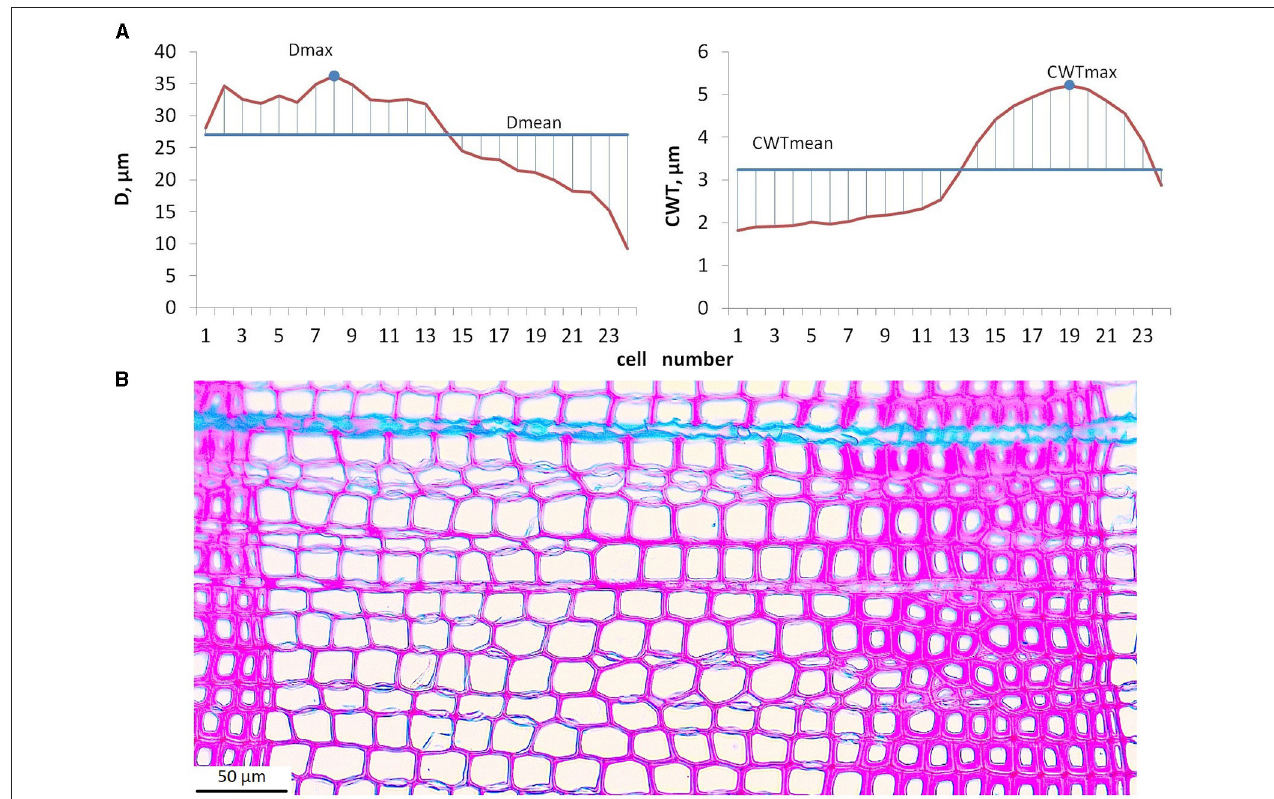
FIGURE 2 | Calculation procedure for maximal and mean values of cell traits: averaged tracheidograms of radial diameter, D and cell wall thickness, CWT (A) ; microphotograph of tree ring formed during 1903 in tree #6 used as an example for calculation (B)